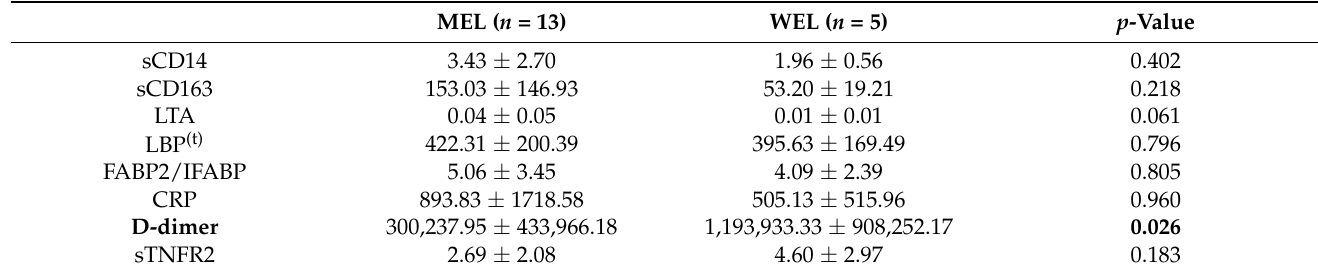
Table A8. Inflammatory biomarkers (ng/mL) by dietary patterns in